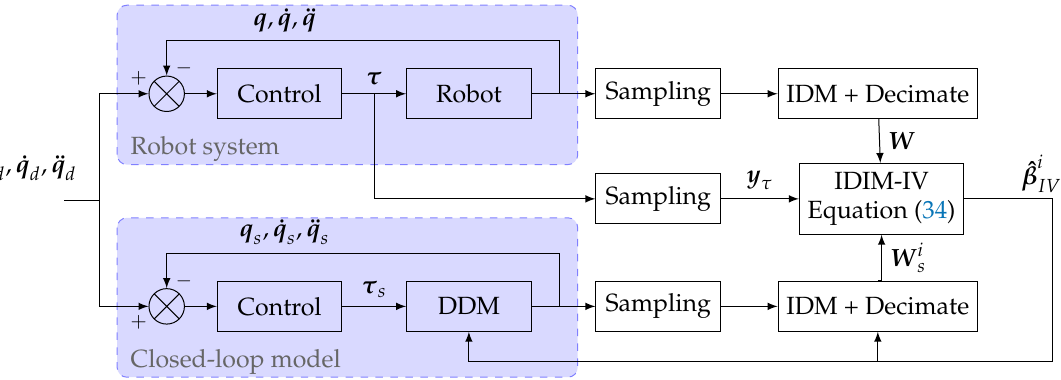
Figure 1. Block diagram of the IDIM-IV identification